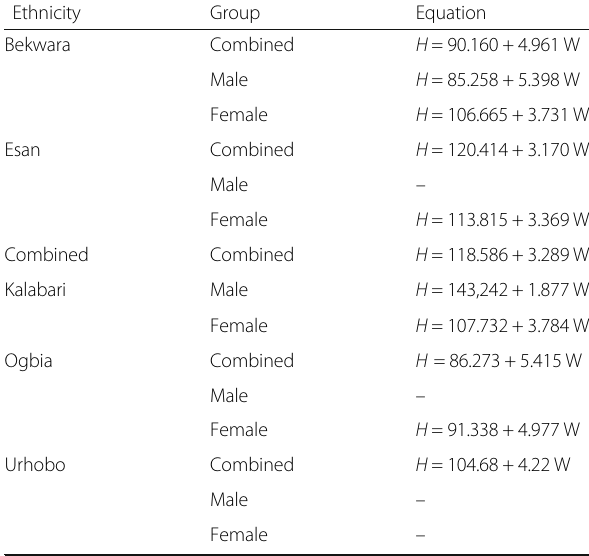
Table 7 Simple regression formulae for stature estimation using head width